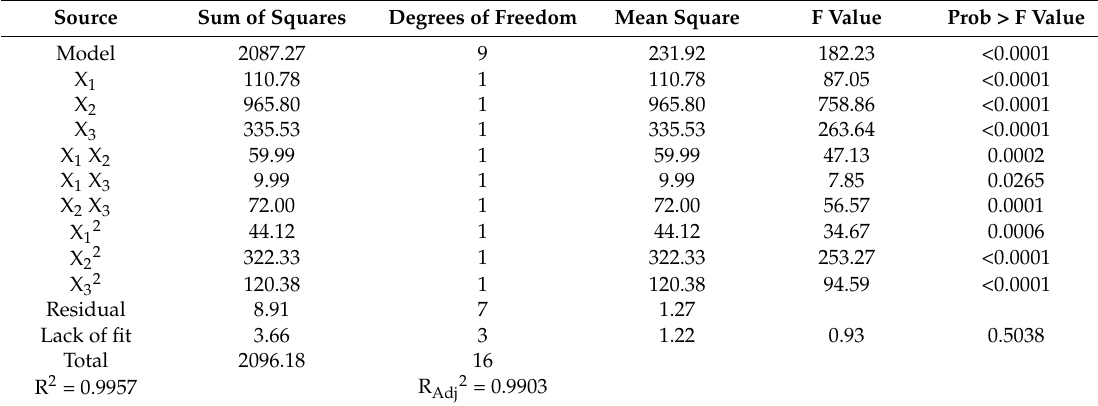
Table 2. Analysis of variance (ANOVA) for the quadratic model for the hydrolysis ratio of CO.